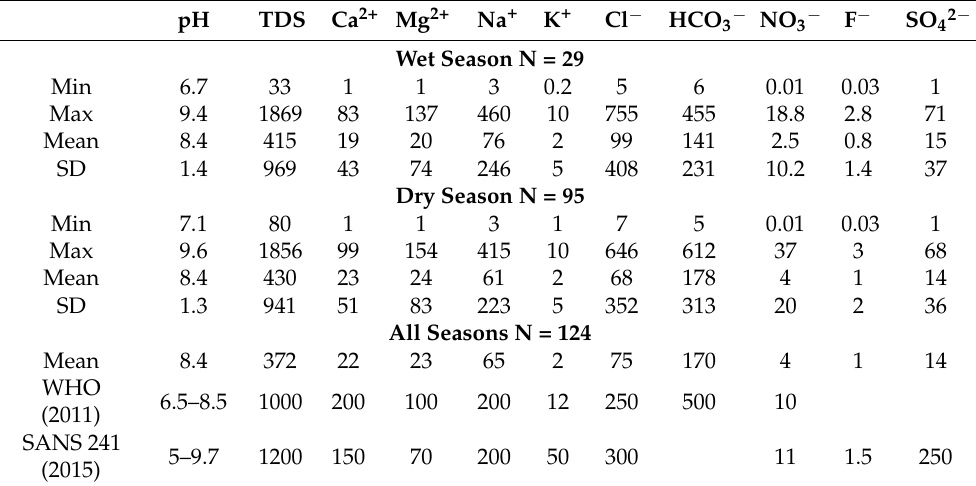
Table 1. Descriptive statistical analysis of physiochemical parameters. Table 2. Correlation coefficients of major physiochemical parameters in the Soutpansberg region.